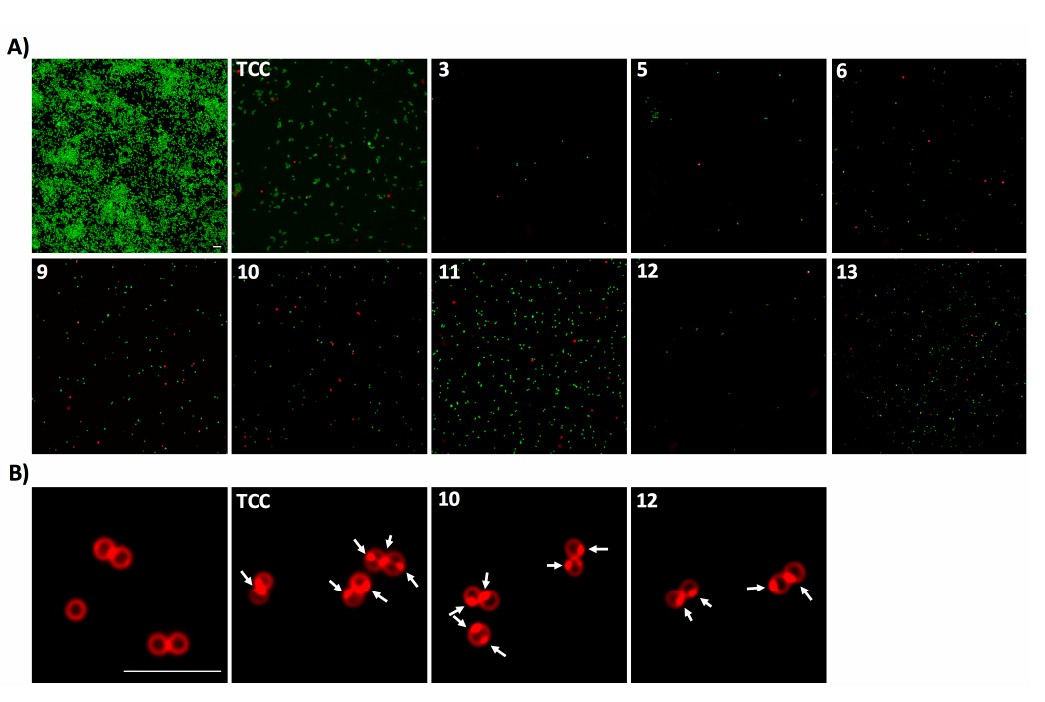
Figure 3. ( A ) Live/Dead analysis of S. aureus . Green fluorescence indicates live cells, and red fluorescence suggests dead cells. ( B ) Membrane damage analysis by FM 4-46 staining. Scale bar correspond to 5 µm.